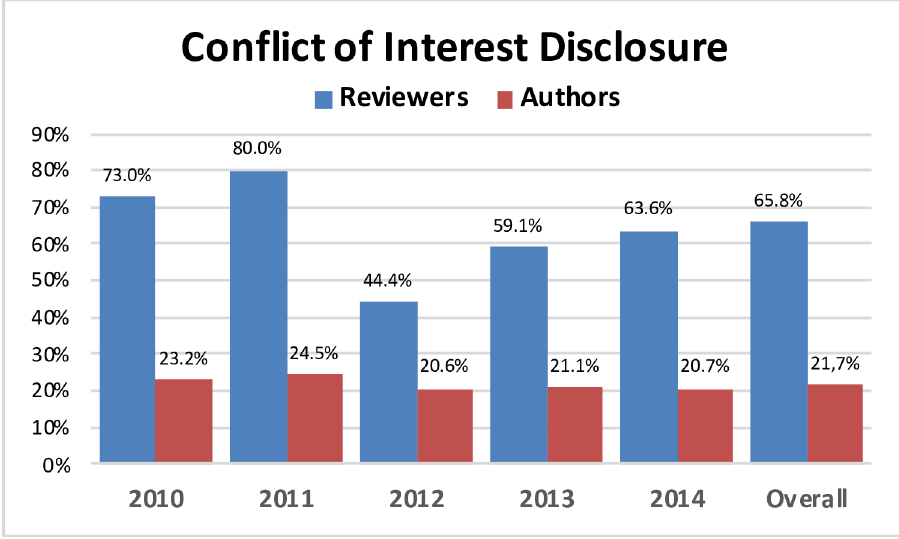
Fig 2. Distribution of COI (in percentages) by years differentiating reviewers and authors. (p < 0.001 for each year and overall